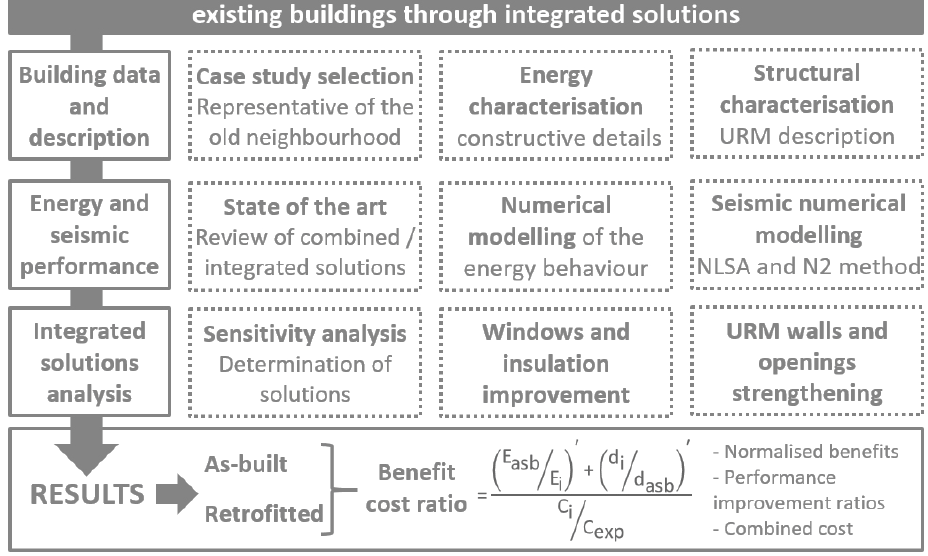
Figure 1. Flowchart of the